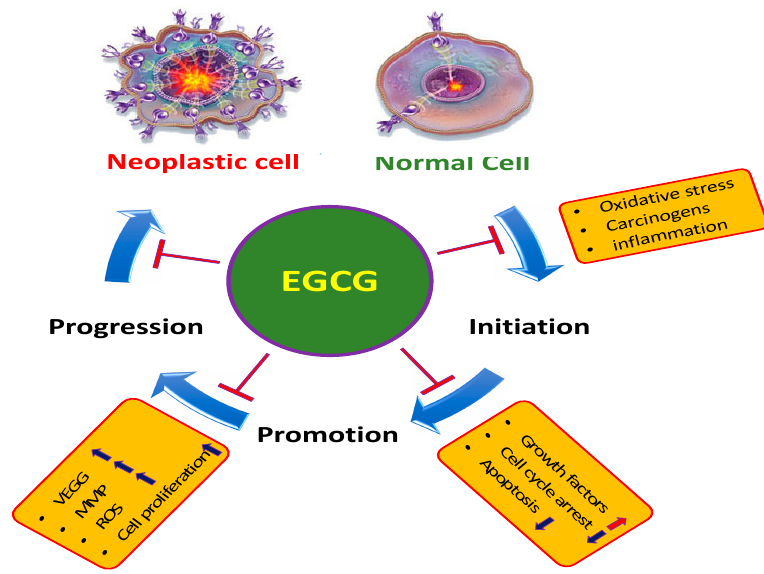
Figure 1. Epigallocatechin-3-gallate (EGCG)’s role in inhibition of cancer formation through inhibiting carcinogenesis process.